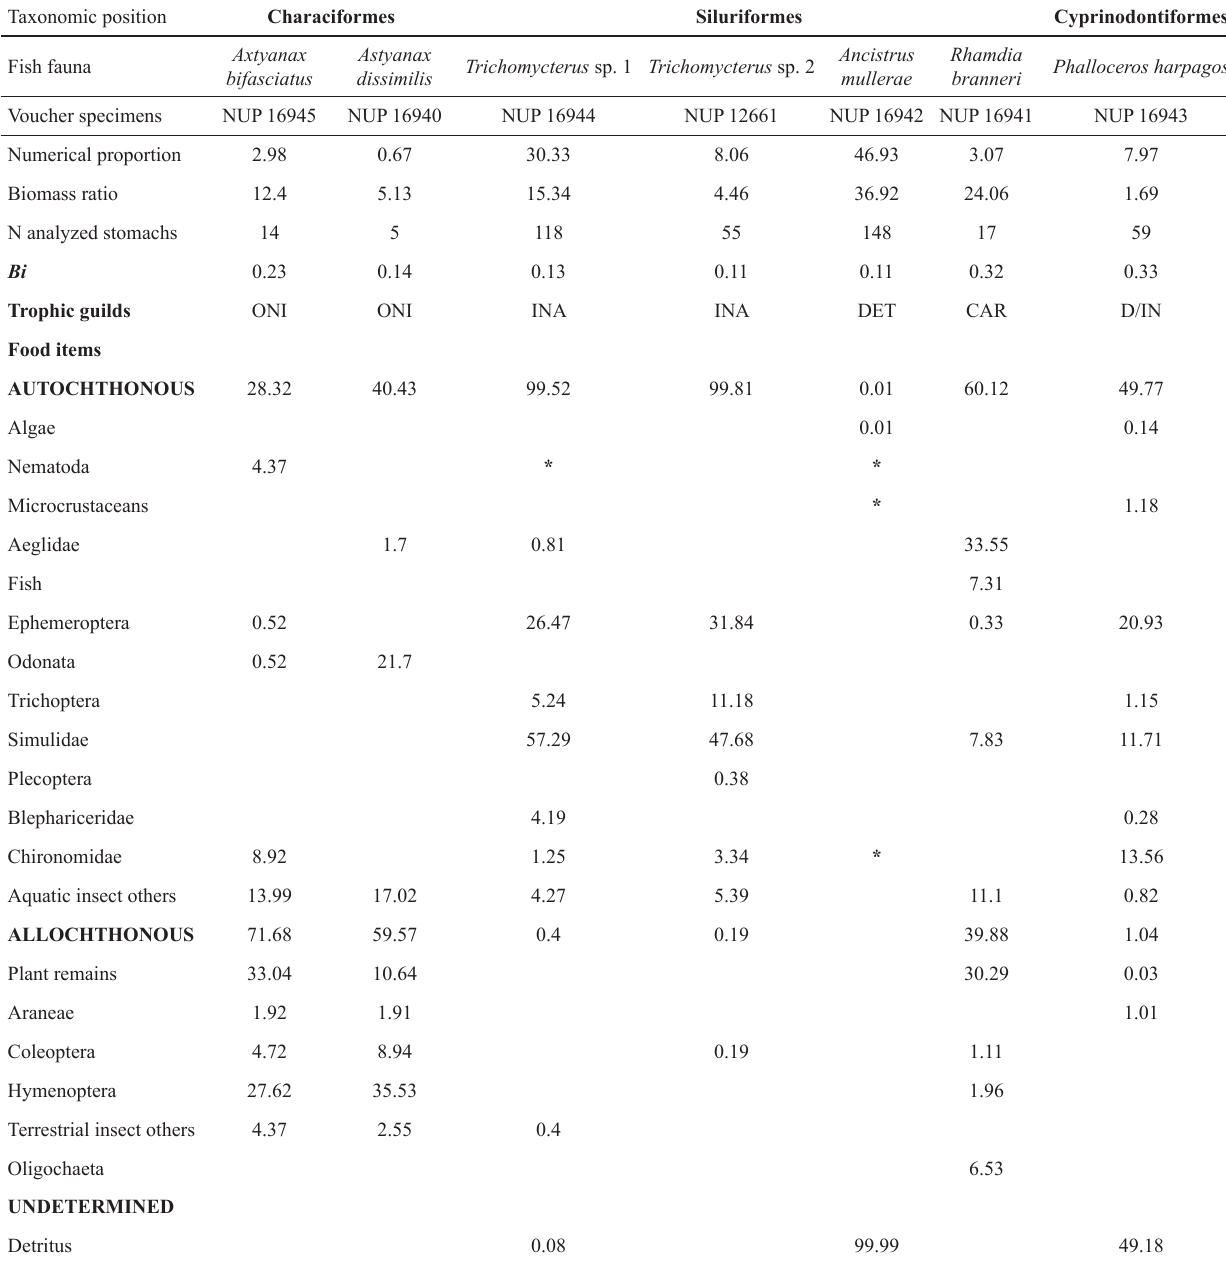
Table 1 . Food items consumed by the fish fauna in Jumelo stream, Iguaçu National Park, Paraná, Brazil. Values based on data for percentage volume of the food item. Asterisk indicates values less than 0.01%. Trophic guilds: DET= detritivore; CAR= carnivore; ONI= omnivore; INA= aquatic insectivore; D/IN= detritivore/insectivore; Bi : Standardized Levins niche